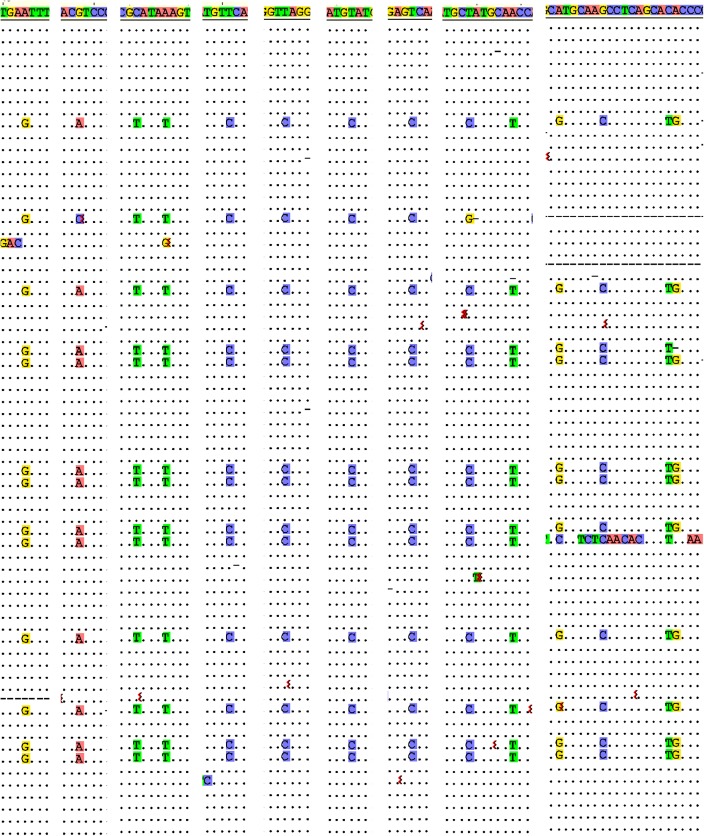
Extracted columns of conserved patterns of nucleotide changes.Nine regions were extracted from an alignment of CCS reads that assembled to a specific minicircle sequence class. Conserved patterns of single nucleotide changes in 14 columns in these regions are highlighted. See Fig 4 legend for details.